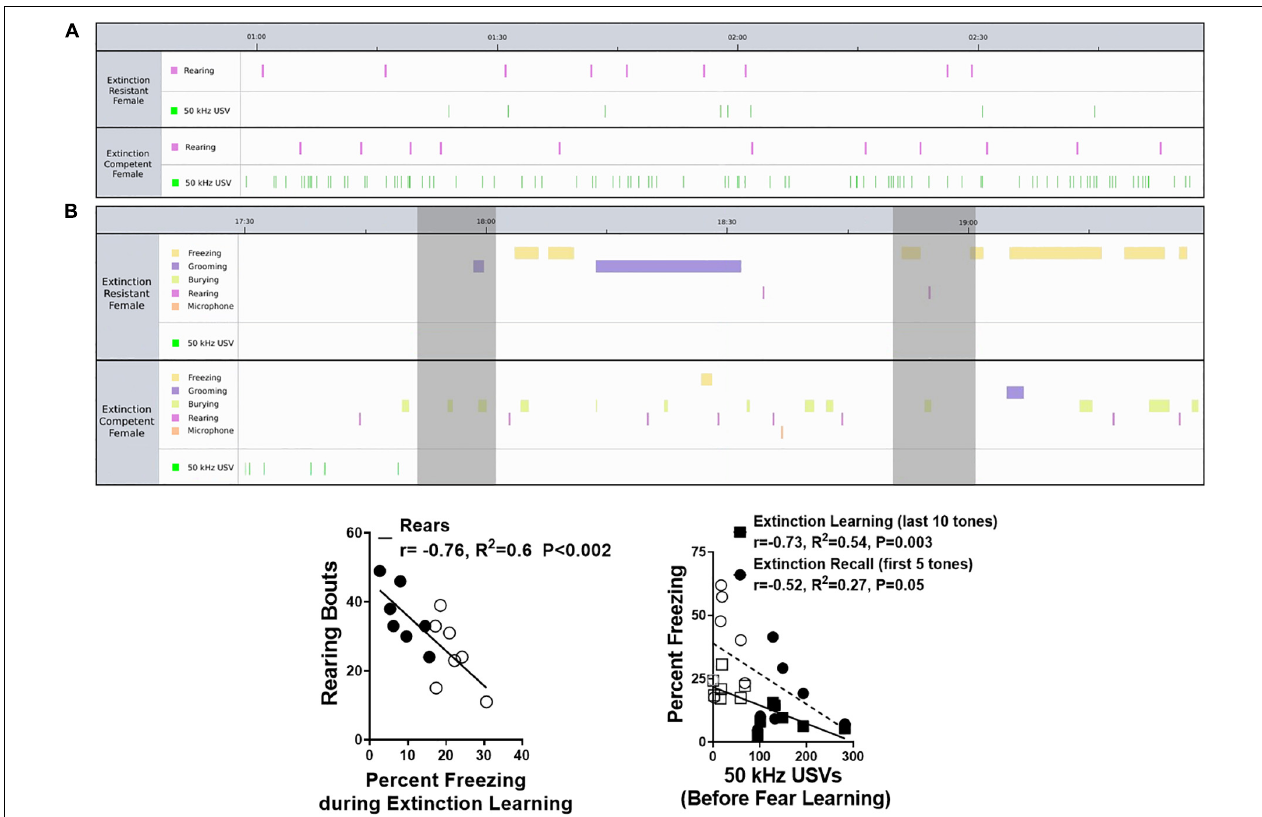
FIGURE 5 | Representative ethograms from extinction resistant (ER) and extinction competent (EC) females comparing behaviors and ultrasonic vocalizations (USVs) prior to fear learning (A) and during extinction learning (B) . Ethograms in panel (A) show 2 min prior to the tone–shock pairings demonstrating similar numbers of rearing bouts (pink) in the ER and EC rats, but significantly more 50 kHz USVs emitted by the EC female compared to the ER rat during the initial exposure to Context A. Ethograms in panel (B) show freezing (yellow), grooming (purple), burying (light green), rearing (pink), microphone exploration (orange), and 50 kHz USVs (green) in an ER and EC female during 2 min of tone presentation (shaded bars) during extinction learning; this represents tones number 15 and 16 during the last 5 min of extinction learning. Note that the ER female shows more freezing, but less rearing, burying, and 50 kHz USVs, compared to the EC female during this same period of the trial. Panel (C) demonstrates the number of rearing bouts is negatively correlated with the percent freezing during extinction learning. Panel (D) shows the number of 50 kHz USVs during the 3 min prior to fear learning is negatively correlated with the percent freezing during extinction learning and extinction recall, suggesting more 50 kHz USVs during the initial exposure to Context A (prior to any fear conditioning) is associated with better extinction (less freezing) during extinction in females. N = 7 ER and N = 7 EC rats per group. Closed symbols are EC females and open symbols are ER